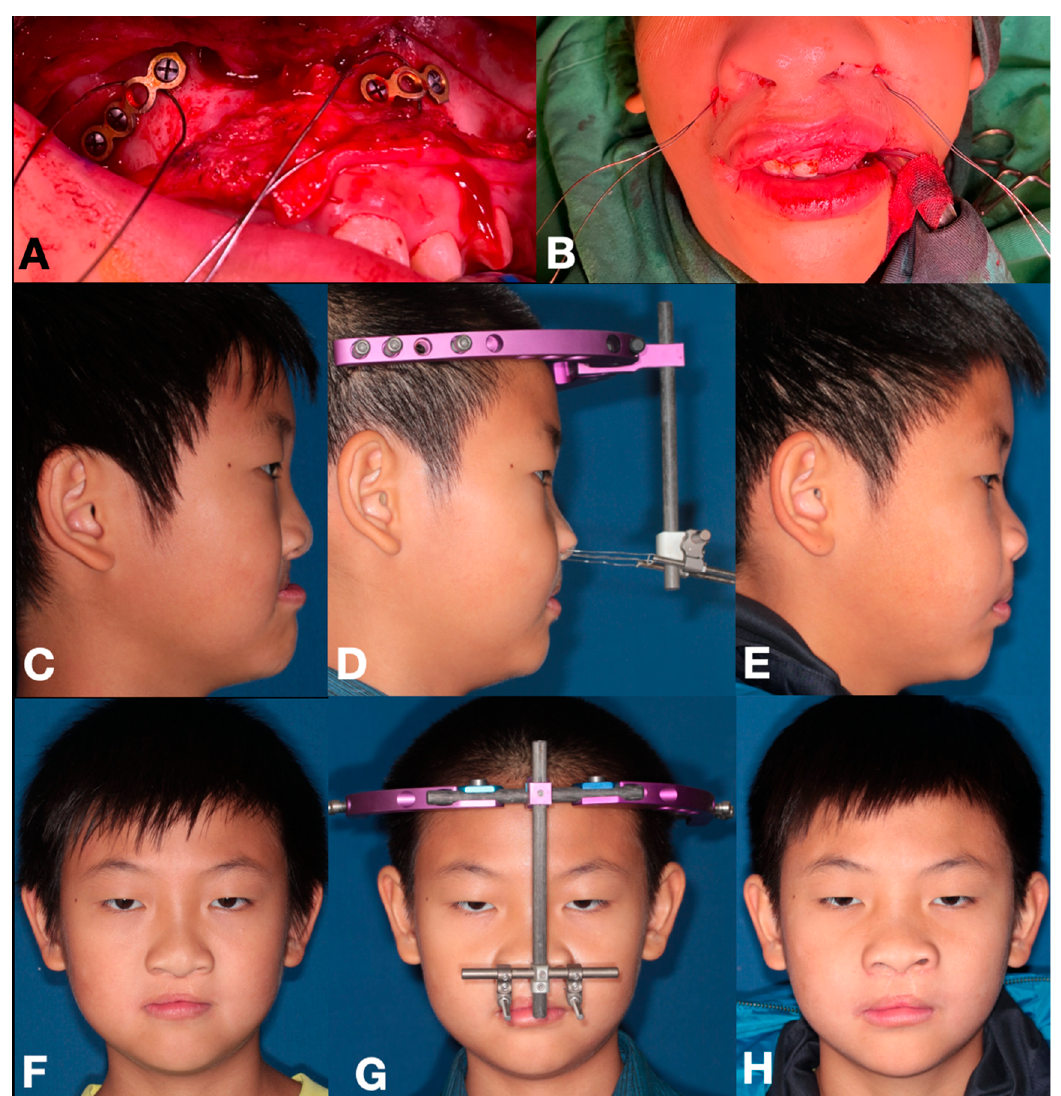
Figure 2. An eleven-year-old boy with cleft-related maxillary hypoplasia was treated with the bone- borne RED system for distraction osteogenesis. ( A , B ) Two miniplates were fixed with five bone screws on the osteotomized maxillary bony surface. Transcutaneous wires were ligated into the two un-screwed holes of the miniplates below LeFort I osteotomy line, and the wires were extended from the lateral sides of alar base. ( C – E ) Lateral profile changes before surgery, immediate after distraction, and after 1.5-year review. ( F – H ) Frontal appearance changes during the three stages mentioned above.